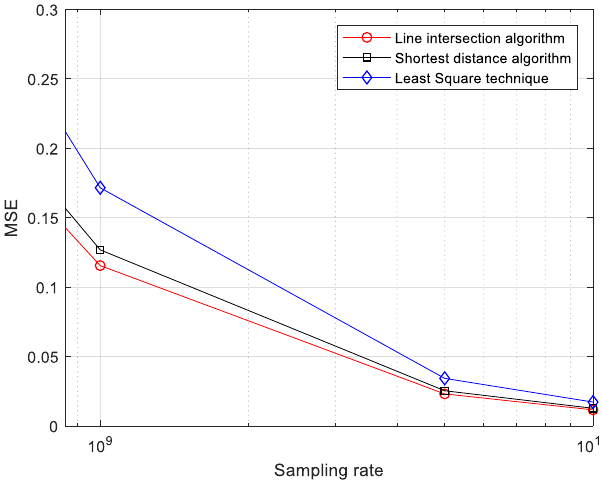
Figure 12. The enlarged MSEs of the MS position estimation for the first case.